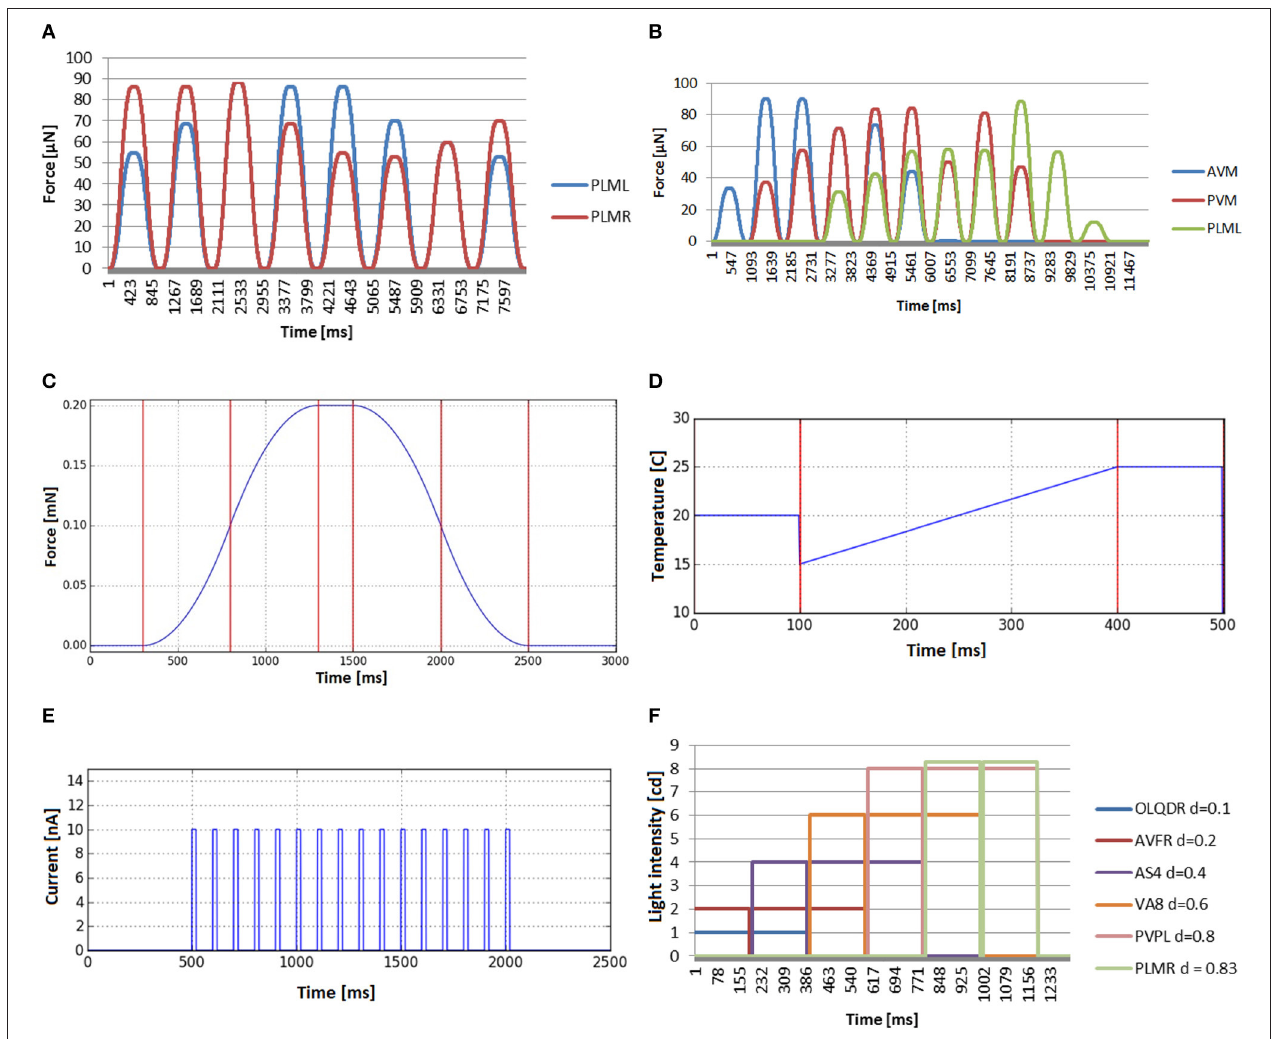
FIGURE 9 | Stimuli that can be computed before simulation starts, because they do not depend on the position of the C. elegans . (A) Mechanosensation in the tail (neurons PLML and PLMR), changing the application angle (from top of the worm going around the transversal plane in counter-wise manner). (B) Stimuli received by three neurons that are located in different lenths of the nematode (AVM, PVM and PLML) when the worm is touched along the body. (C) Bell-shaped stimulus received by any mechanosensory neuron when tapping the plate that contains the C. elegans . (D) Global temperature change received by any thermosensory neuron. Default temperature is set to 20 ◦ C. Temperature changes in time from 15 to 25 ◦ C. After that, the environment temperature keeps the last defined value. (E) Electrical charge stimulus transferred to all neurons in the form of a train of electrical impulses. (F) Stimuli input registered by neurons located at different lengths (OLQDR, AVFR, AS4, VA8, PVPL, and PLMR) when light impulse events, with increasing magnitude, are applied at different locations from the head to the